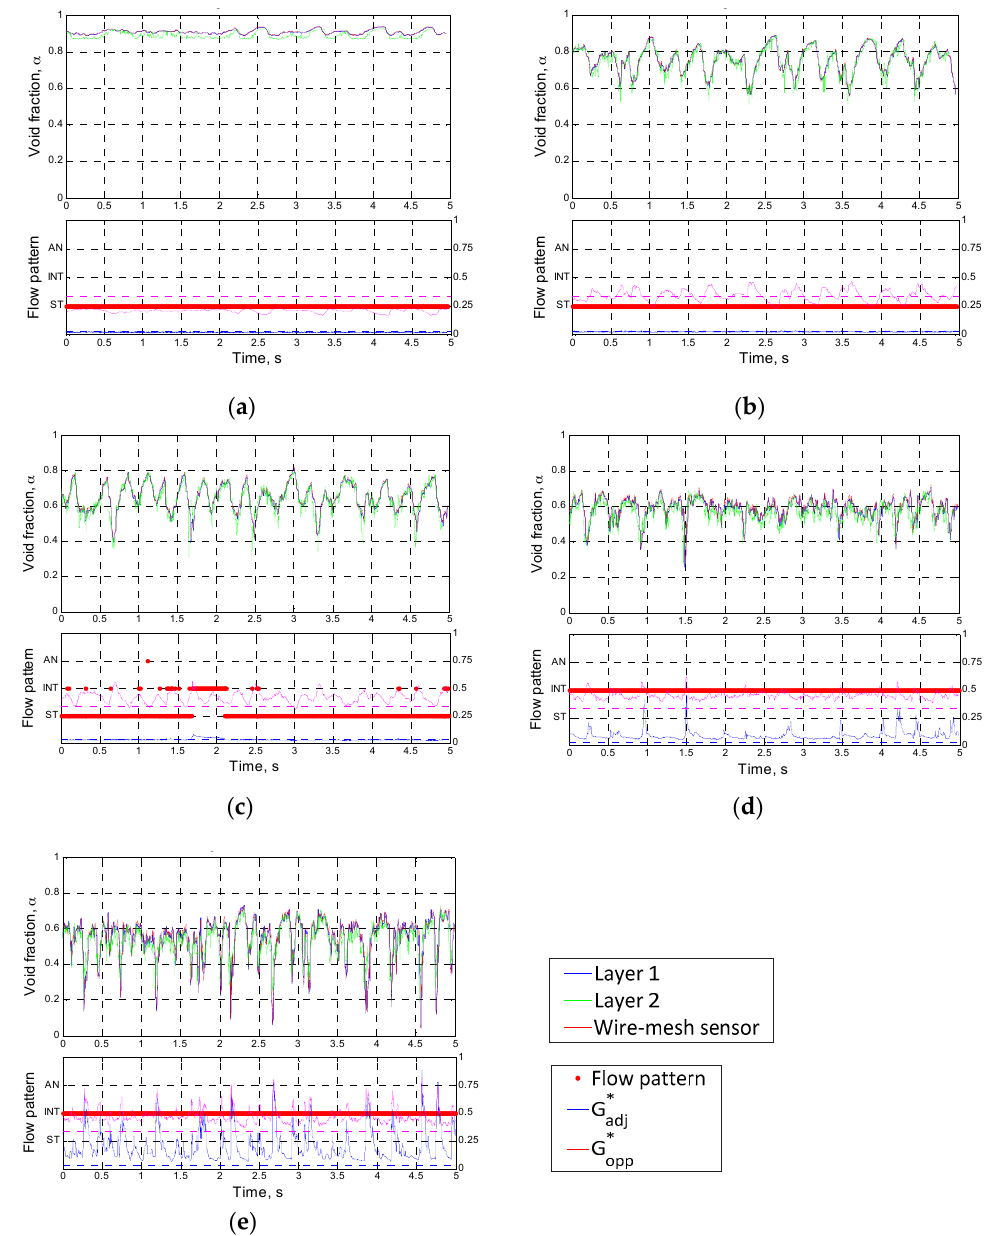
Figure 12. The results of the flow pattern classification and the corresponding time series of the void fraction with varying the liquid superficial velocity (Note: The right Y -axis of the lower graphs indicates the dimensionless conductance.) ( a ) Case 1: j l = 0.1 m/s, j g = 10 m/s, j sv = 1.18 m/s. ( b ) Case 2: j l = 0.5 m/s, j g = 10 m/s, j sv = 1.96 m/s. ( c ) Case 3: j l = 1.0 m/s, j g = 10 m/s, j sv = 2.77 m/s. ( d ) Case 4: j l = 2.0 m/s, j g = 10 m/s, j sv = 4.27 m/s. ( e ) Case 5: j l = 3.0 m/s, j g = 10 m/s, j sv = 6.38 m/s